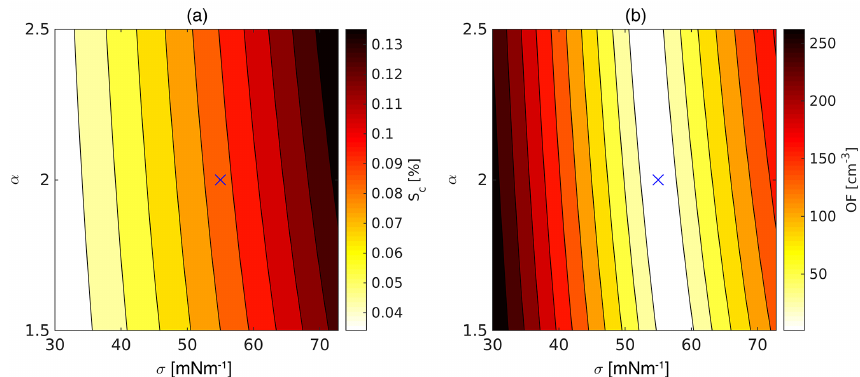
Figure 6. (a) Response surface for the critical supersaturation S c of an r d = 75nm marine average aerosol for perturbations in α and σ across ranges given in Table 2. (b) Response surface of the OF for marine average CCN spectra with respect to the same parameter perturbations as in (a) . Blue cross indicates the true values of the two